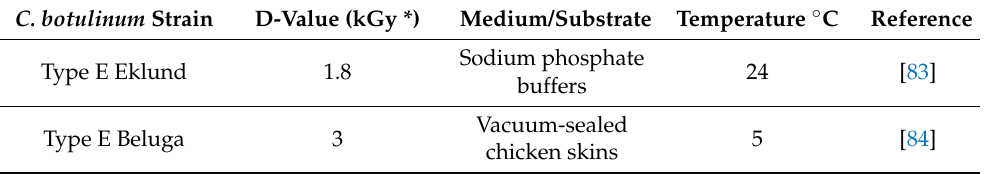
Table 4. Ionizing radiation doses for the inactivation of C. botulinum strains in different food